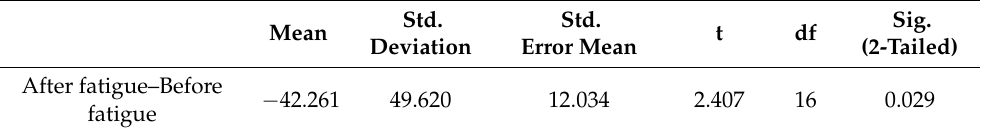
Table 6. Paired samples t -test results for accuracy rate.